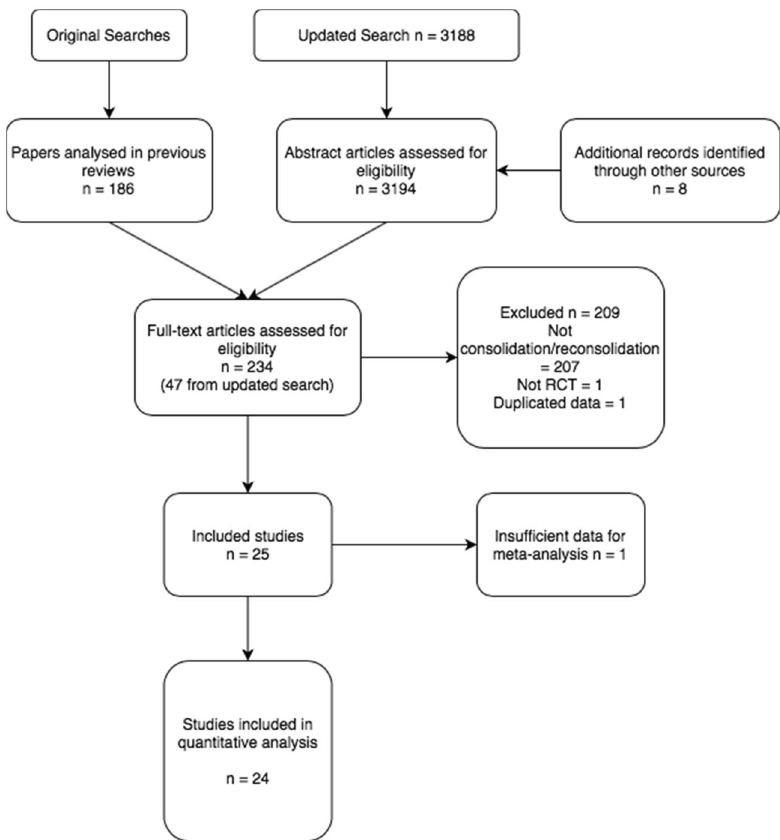
Fig. 1 PRISMA fl ow